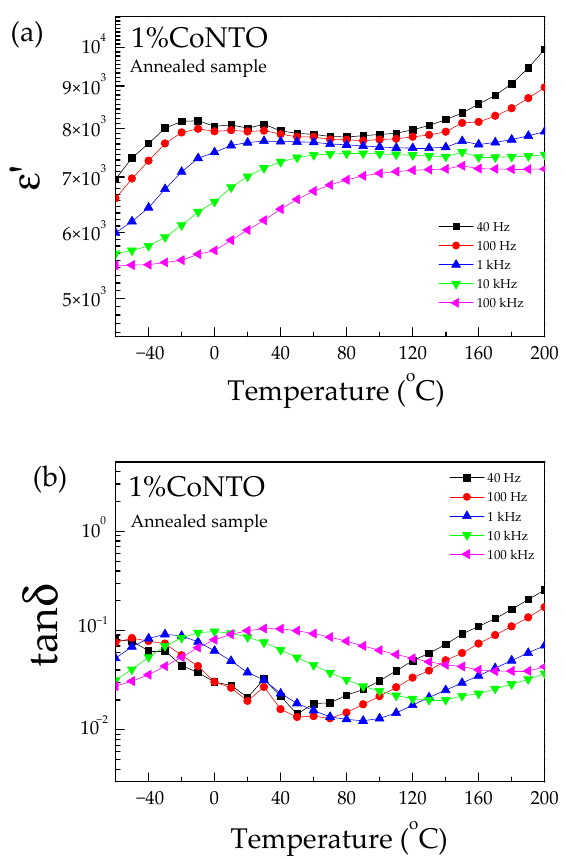
This result indicates that the R i of the 1% CoNTO ceramic was larger than that of the 0.5% CoNTO ceramic. As shown in Figure 2a,b, the mean grain size of the 1% CoNTO ceramic was smaller than that of the 0.5% CoNTO ceramic. Thus, the number of insulating GBs per volume (GB density) of the 1% CoNTO ceramic should be higher than that of the 0.5% Figure 6. Temperature dependences of ( a ) ε′ and ( b ) tan δ of 0.5% CoNTO ceramic. CoNTO ceramic, resulting in the increased R i .